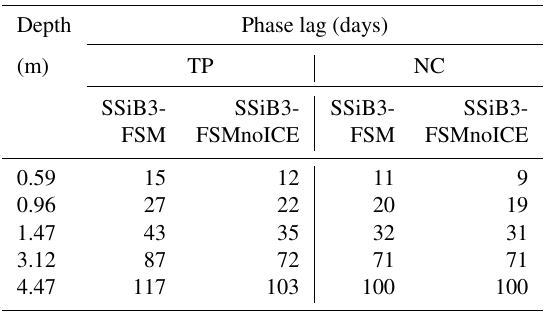
Table 2. Phase lag (days) of simulated soil temperature at different soil depths by SSiB3-FSM and SSiB-FSMnoICE.